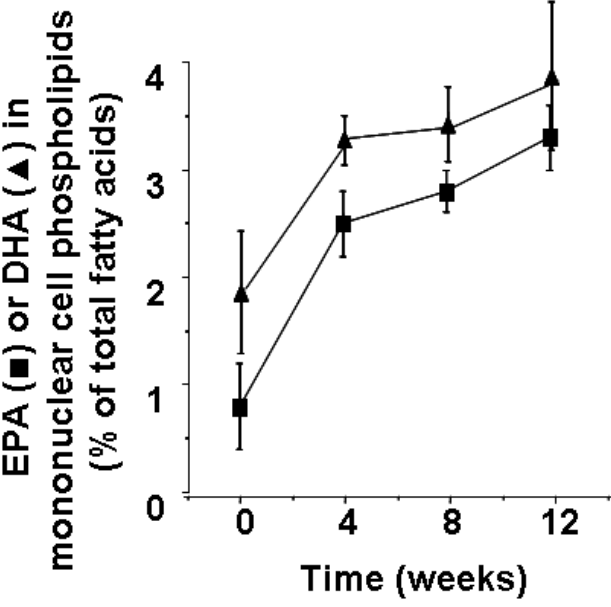
Figure 1. Time course of incorporation of EPA and DHA into human blood mononuclear cells. Healthy subjects supplemented their diet with fish oil capsules providing 2.1 g EPA plus 1.1 g DHA per day for a period of 12 weeks. Blood mononuclear cell phospholipids were isolated at 0, 4, 8 and 12 weeks and their fatty acid composition determined by gas chromatography. Data are mean ± SEM from 8 subjects and are from Yaqoob et al.